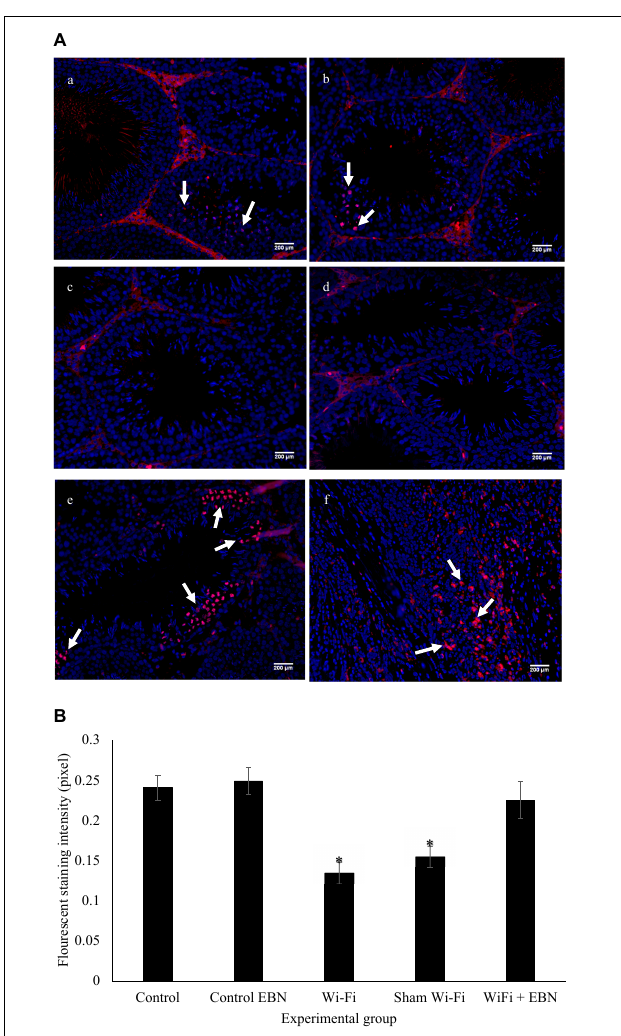
FIGURE 2 | (A) Immunofluorescence staining on sections of the testis for the expression of pHH3 by using Alexa Flour 594, with excitation and emission wavelengths of 590 and 618 nm, respectively. Positive staining is represented by red fluorescence signal (arrow). (a) Control group; (b) Control EBN group; (c) Wi-Fi group; (d) Sham Wi-Fi group; (e) Wi-Fi + EBN group (f) staining positive control by using rectum adenocarcinoma tissue section. For each section, Hoechst 33342 was used to counterstain the cell nuclei, as indicated by the blue signal. All observations were conducted under 200 × magnification. (B) Immunofluorescence intensity measured by Image J is presented as median ± SEM ( n = 6). Kruskal-Wallis H test showed significant differences * among the groups (Chi-square = 24.84, p = 0.000, df = 2).